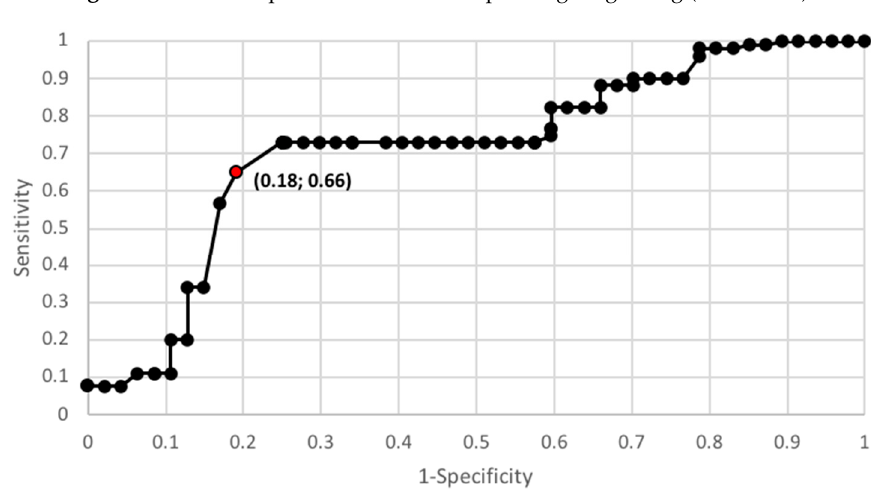
Figure 2. Galectin 3 protein ROC curve depending on staging (AUC = 0.89).